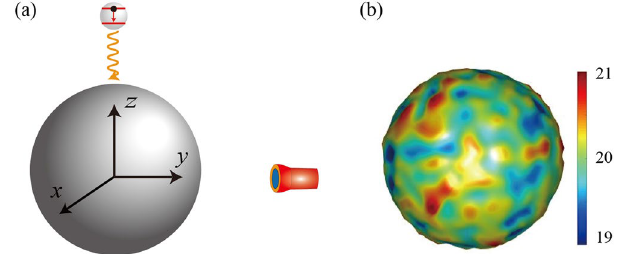
Figure 1. ( a ) Schematic of a 20-nm-radius MNP embedded in vacuum couples with a two-level QE. The QE is located 22 nm above the MNP center along the z-axis. A far-field spectrum detector is placed 1020 nm away